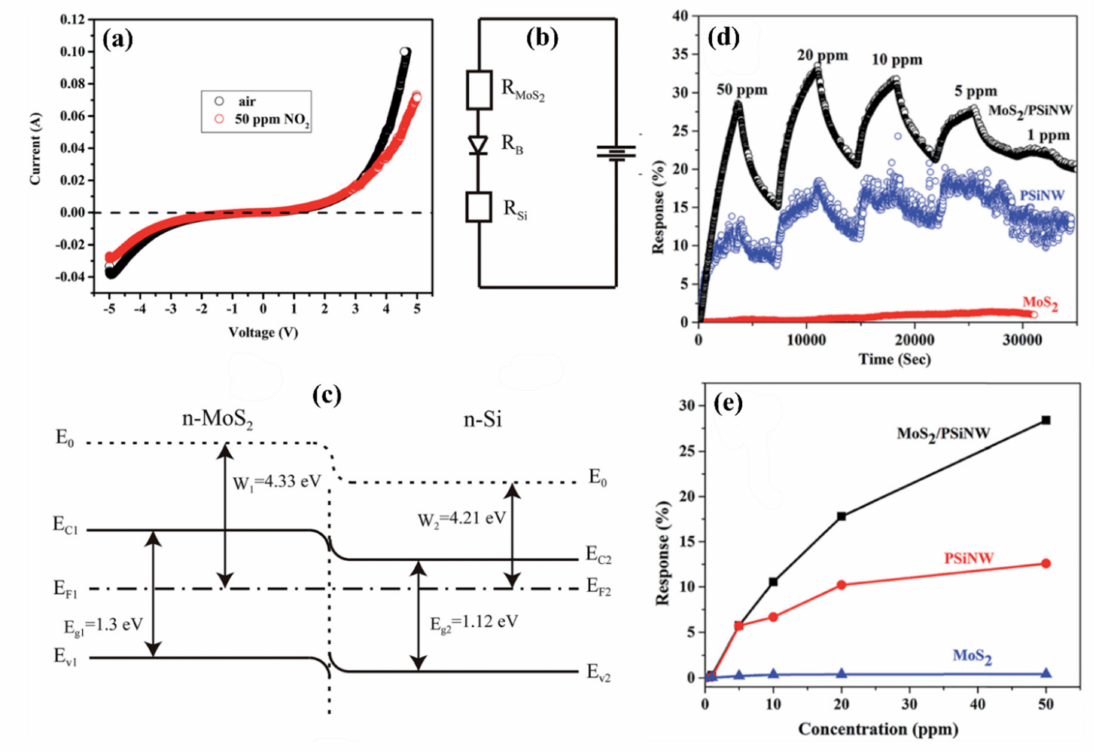
Figure 23. ( a ) I–V curves of MoS 2 / SiNW heterojunctions in air and NO 2 , ( b ) Equivalent electrical resistance model of MoS 2 / SiNW heterojunctions schematic illustration of using CVD to grow MoS 2 nanosheets on PSiNWs, and ( c ) Schematic illustration of the energy band of MoS 2 / SiNW heterojunction structures, and ( d ) Dynamic response in di ff erent NO 2 concentrations, and ( e ) response values of NO 2 concentrations. Reproduced from